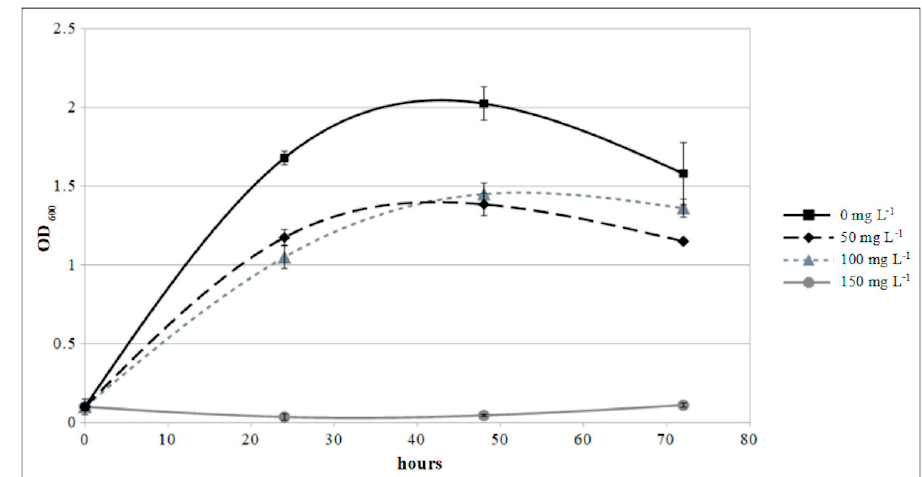
Figure 7. Time courses of microbial growth of P. protegens MP12 in presence of 0, 50, 100, and 150 mg L − 1 of Cu 2+ .